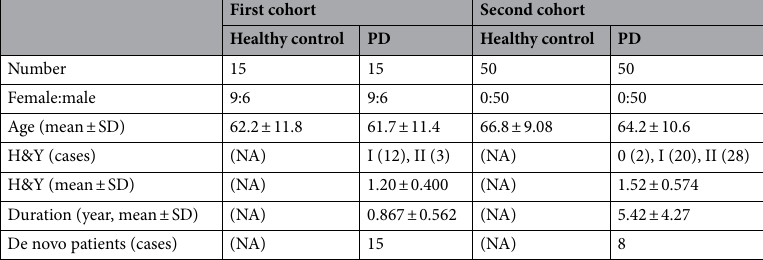
Table 1. Characteristics of participants. NA not available, SD standard